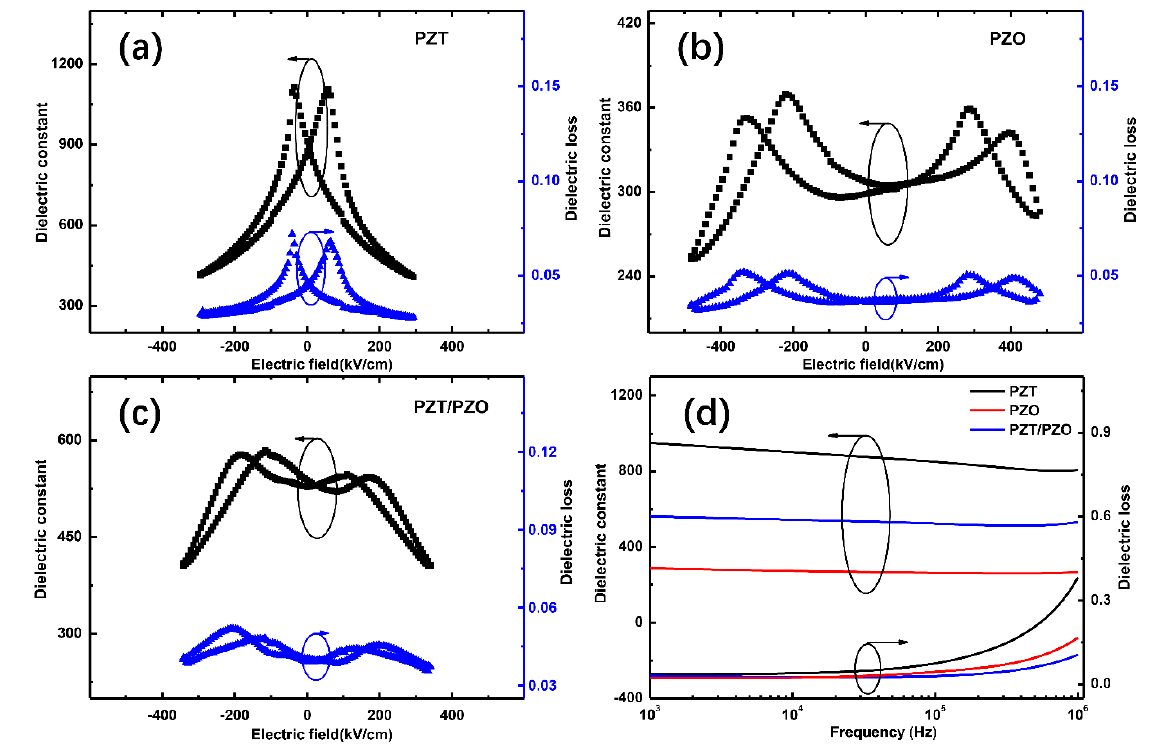
Figure 6. Dielectric properties of ( a ) PZT, ( b ) PZO, and ( c ) PZT/PZO multilayer films as a function of DC electric field at 1 kHz; ( d ) frequency dependence dielectric properties from 1 to 1000 kHz at room temperature.